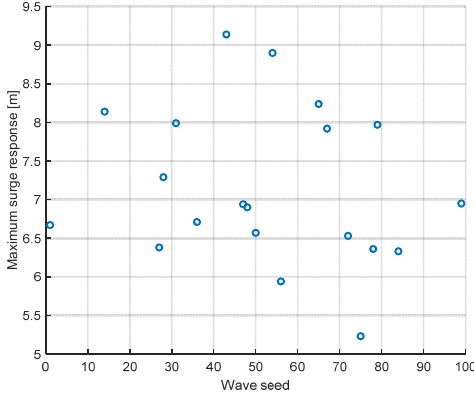
Figure 20. Maximum mooring tensions for different seed numbers.